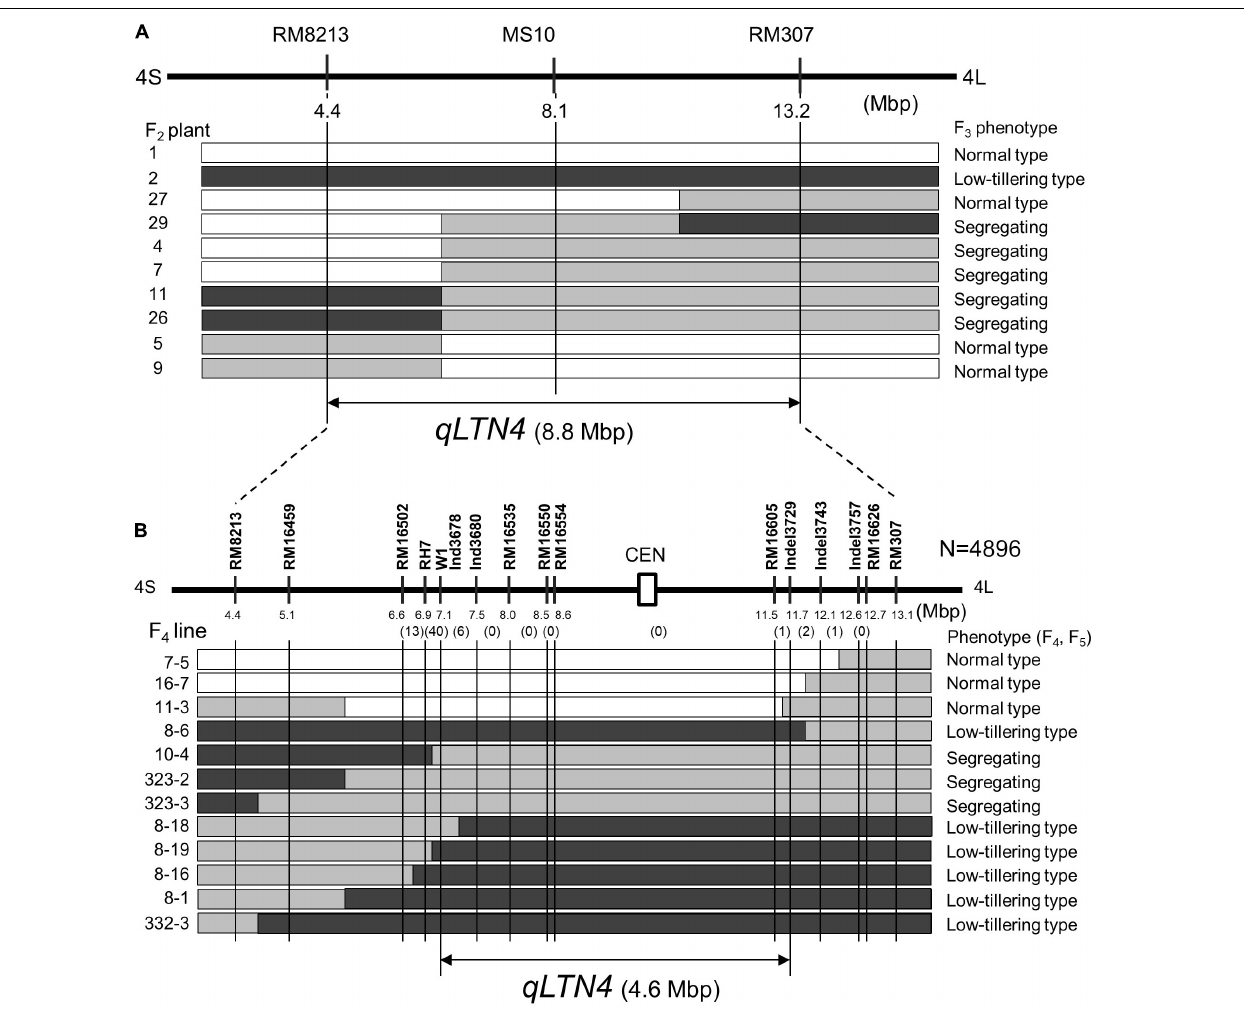
There were no significant differences for CL, PN, LL, and LW between T65 and BC 5 F 1 plants. Several traits related to panicle architecture, i.e., TSPB, TSSB, and TSN, were significantly lower in the low-tillering line than in T65. The grain fertility of the